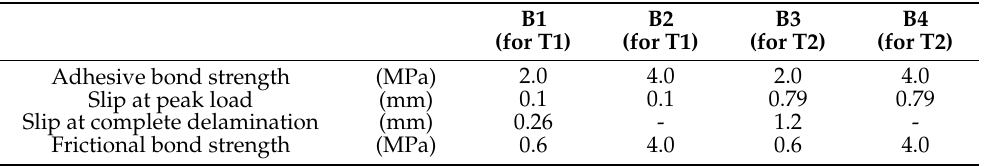
Table 3. Numerical parameters defining the bond-slip